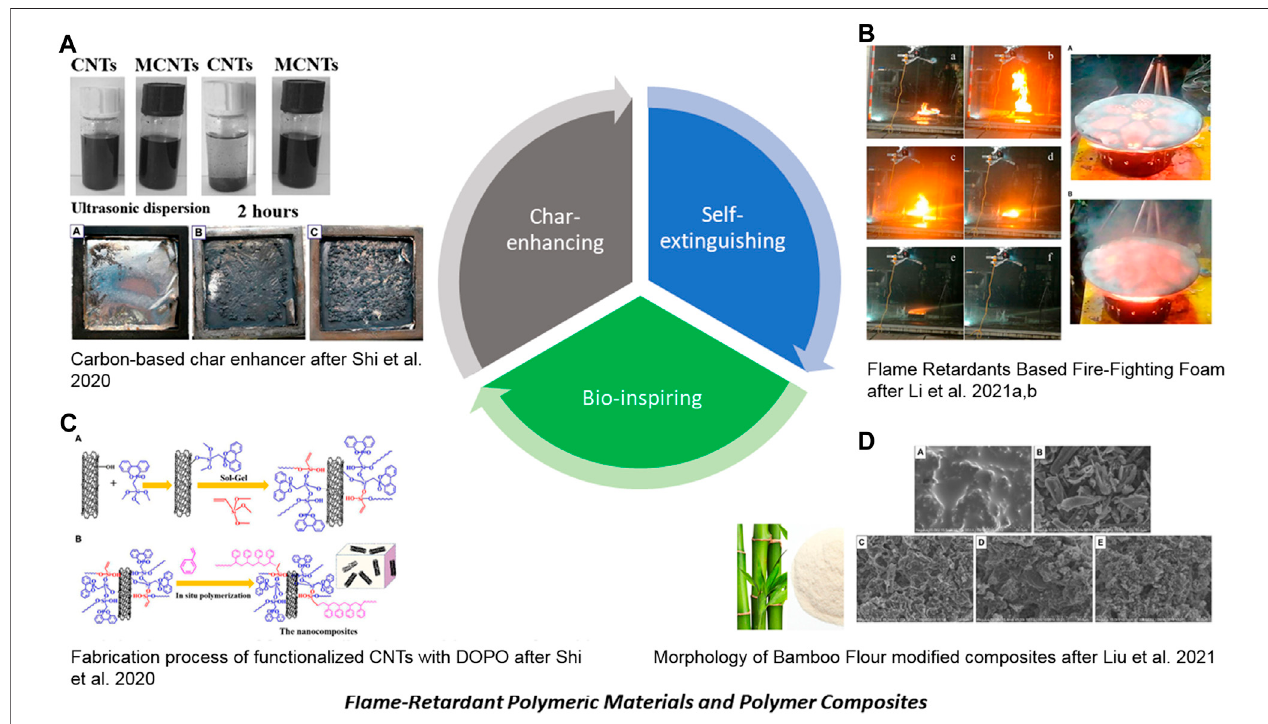
FIGURE 1 | Advancement and driving mechanisms of fl ame-retardant technologies for polymer composites. Images in (A) , (B) , (C) and (D) are adapted from Shi et al. (2020), Li et al. (2021a), Li et al. (2021b), and Liu et al. (2021) respectively, published under the terms of Creative Commons Attribution 4.0 (CC BY 4.0).